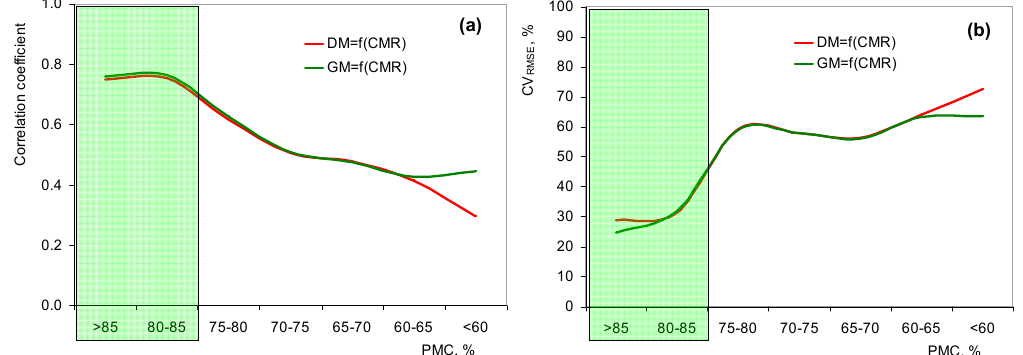
Figure 6. Evolution of the correlation coefficient ( a ) and coefficient of variation of the root mean square error (CV RMSE ; ( b )) of the green matter (GM) and dry matter (DM) prediction equations, based on pasture moisture content (PMC) classes considered in the calibration phase .